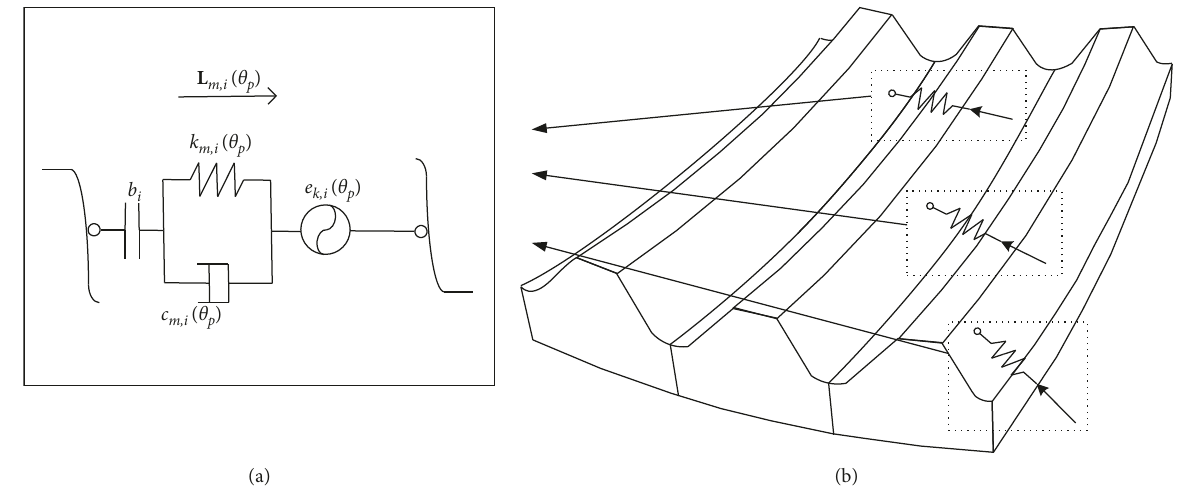
Figure 5: Illustrations of the (a) mesh model of a tooth pair and (b) multipoint coupling mesh model.